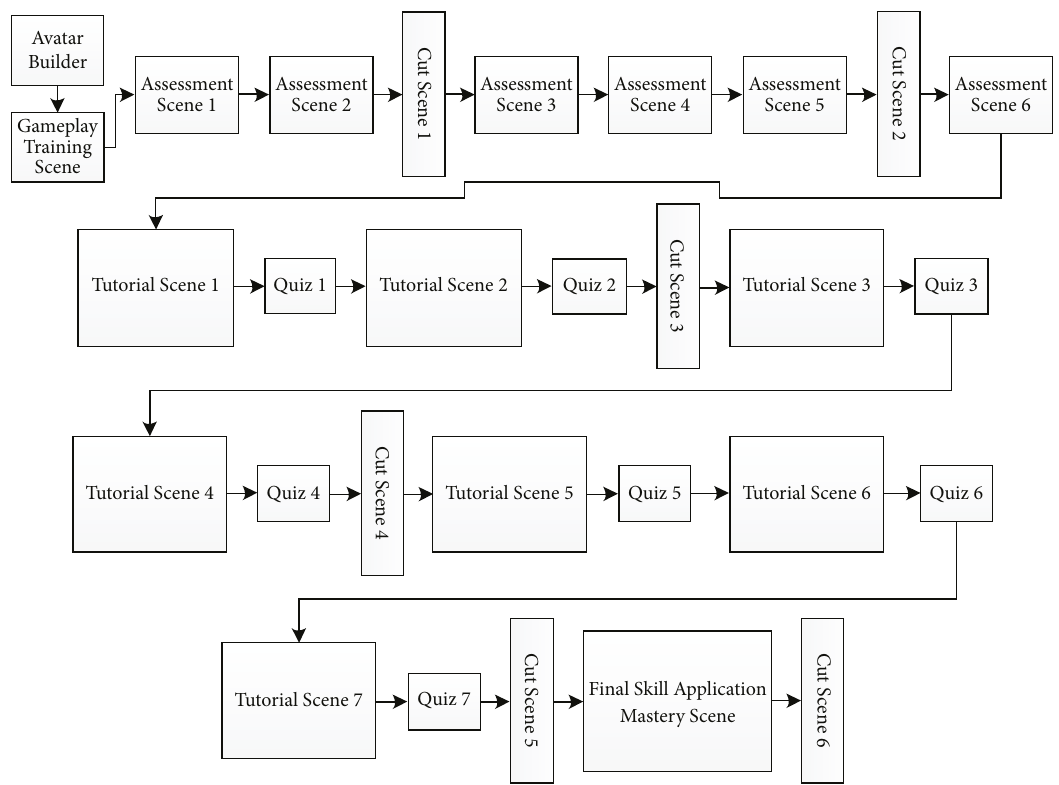
Figure 1: Hall of Heroes scene flow